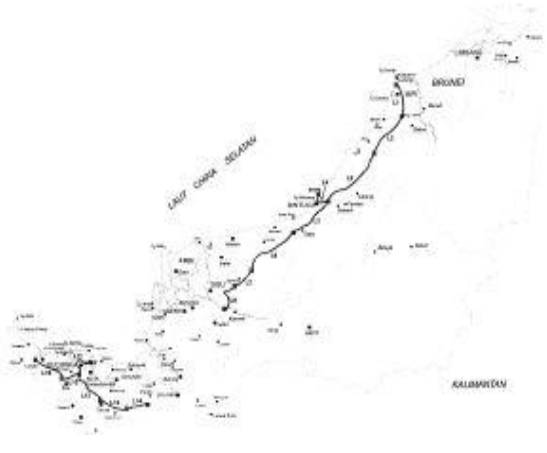
Figure 1. Levelling network established around Kuching and Miri-Sibu 2.2 The development of extended levelling network up to